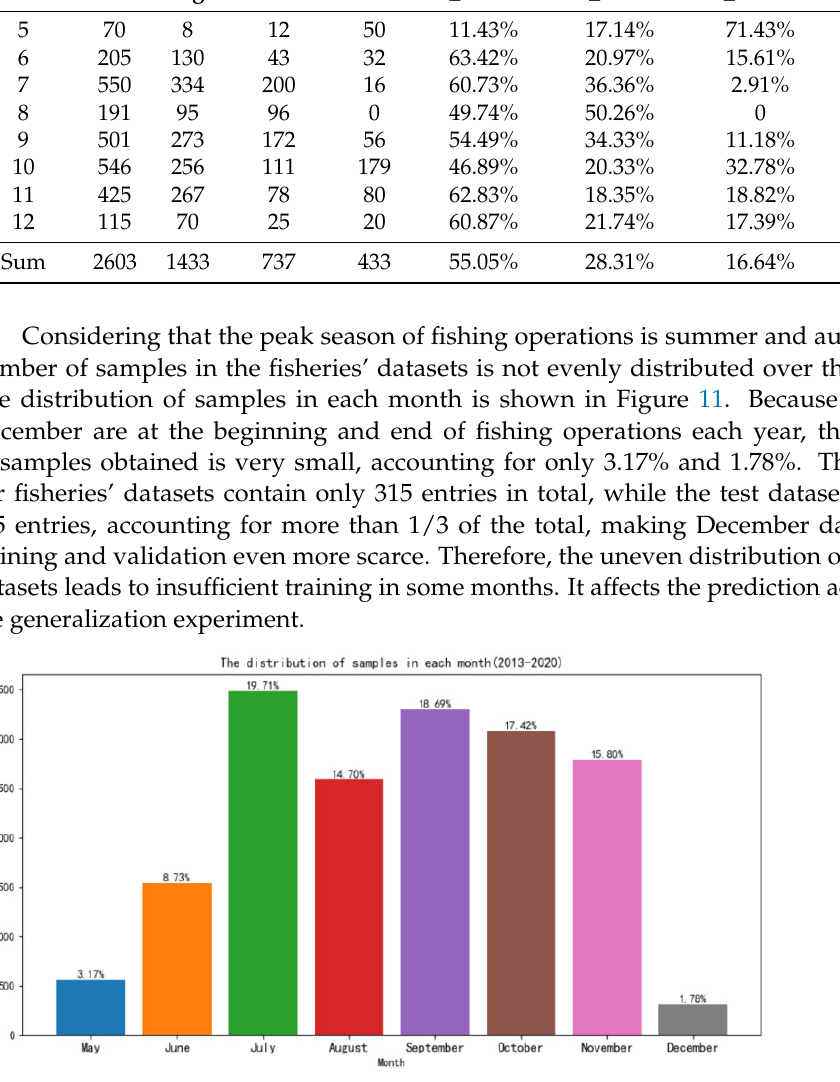
Figure 11. The distribution of samples of fisheries’ datasets in each month in 2013~2020.